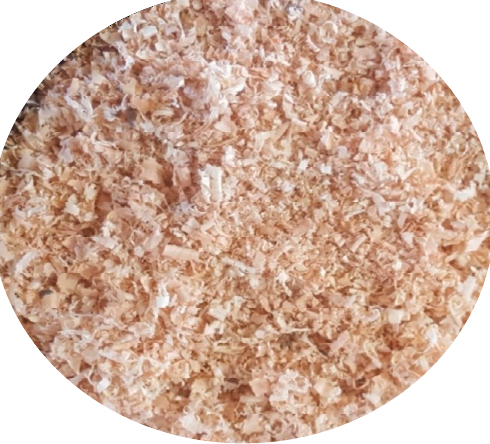
Figure 4. Wood shavings used as the filter medium for all treatments.